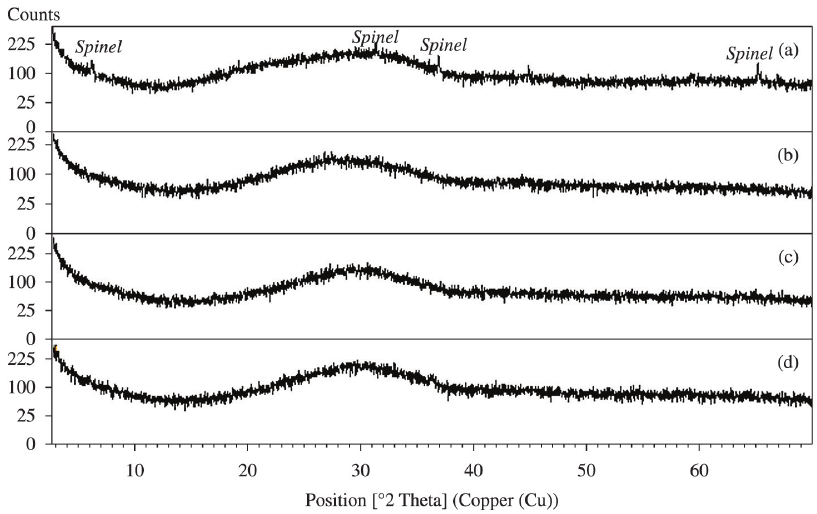
Figure 2. X-ray diffraction spectra of rock wools fabricated using only granite waste (a), only steelmaking slag (b), both residues (c), and from a industrial sample